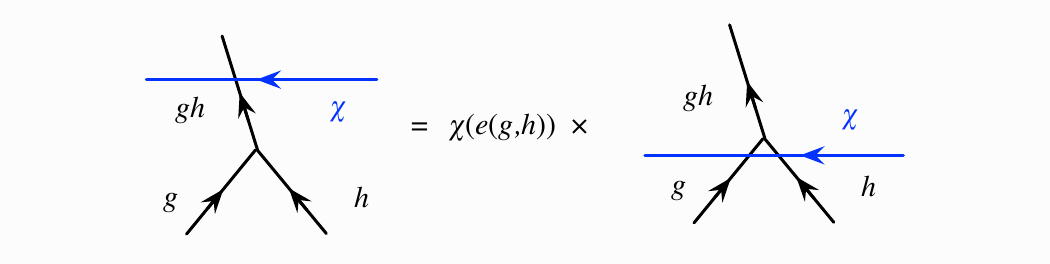
Figure 6: Summing over the A -walls, we now have a mixed anomaly between ˆ A and G